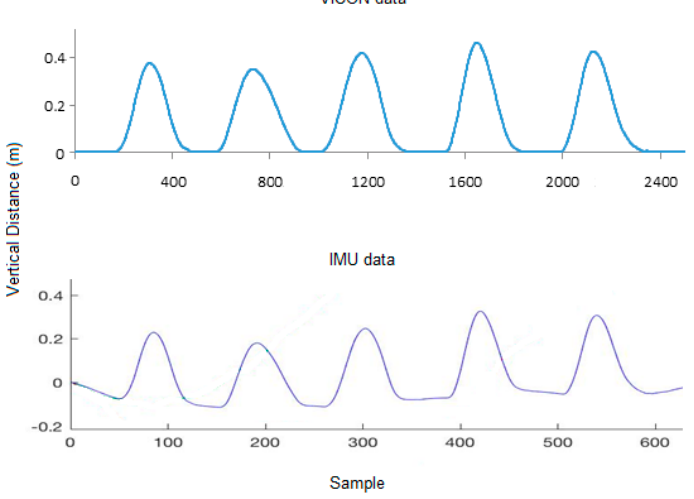
Figure 5. A synchronized test data obtained from 3D motion capture (VICON data, top, sampling rate 200 Hz) and our IMU device without calibration (IMU data, bottom, sampling rate 50 Hz).